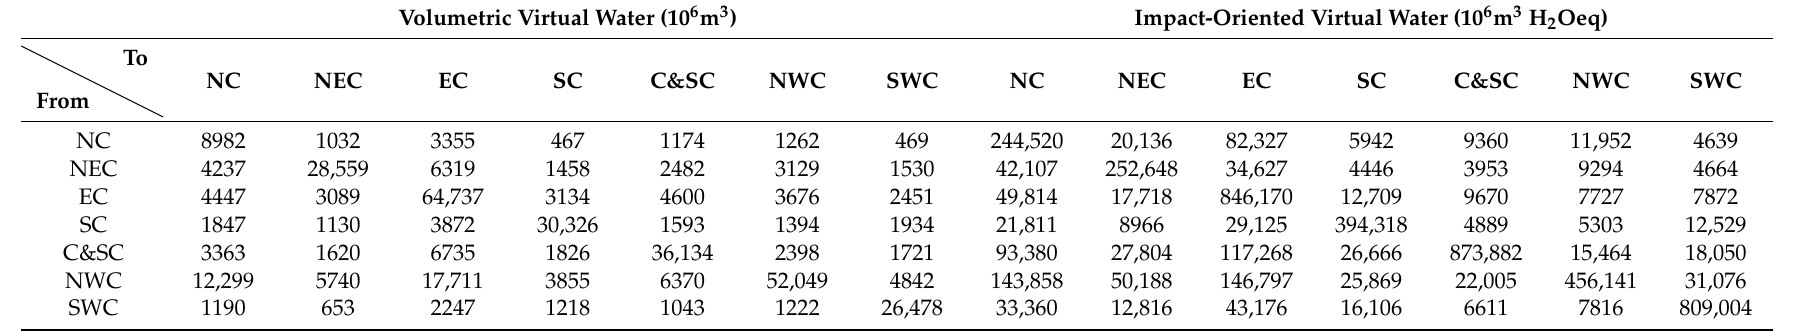
Table 3. Volumetric and impact-oriented agricultural virtual water flow for China in